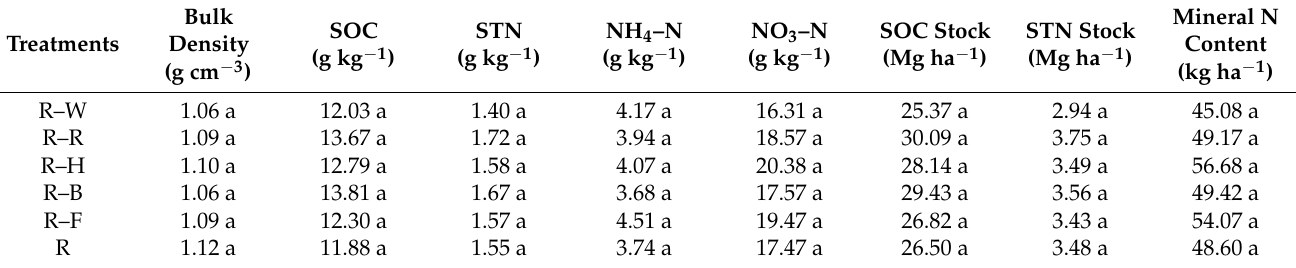
Table 2. Effects of rice-based cropping systems on soil organic carbon and nitrogen stocks in topsoil (0–20 cm layer, in